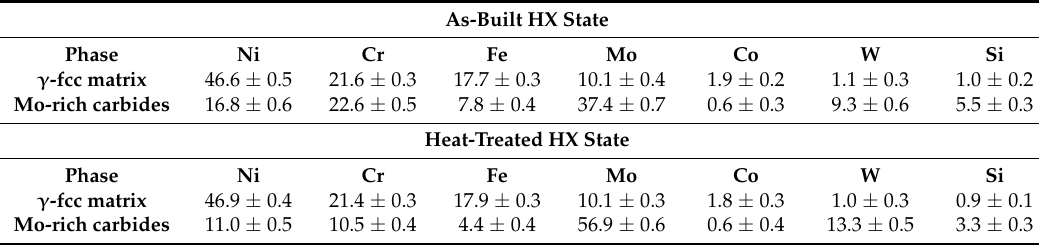
Figure 7. ( a ) SEM image in BSE mode of extracted Mo-rich carbides of as-built HX samples; ( b ) XRD data of extracted carbides from as-built HX samples; ( c ) SEM image in BSE mode of extracted Mo-rich carbides of heat-treated HX samples; ( d ) XRD data of extracted carbides from heat-treated HX samples. Table 3. EDS results in wt % of γ -fcc matrix and extracted Mo-rich carbides of as-built and heat-treated HX samples.